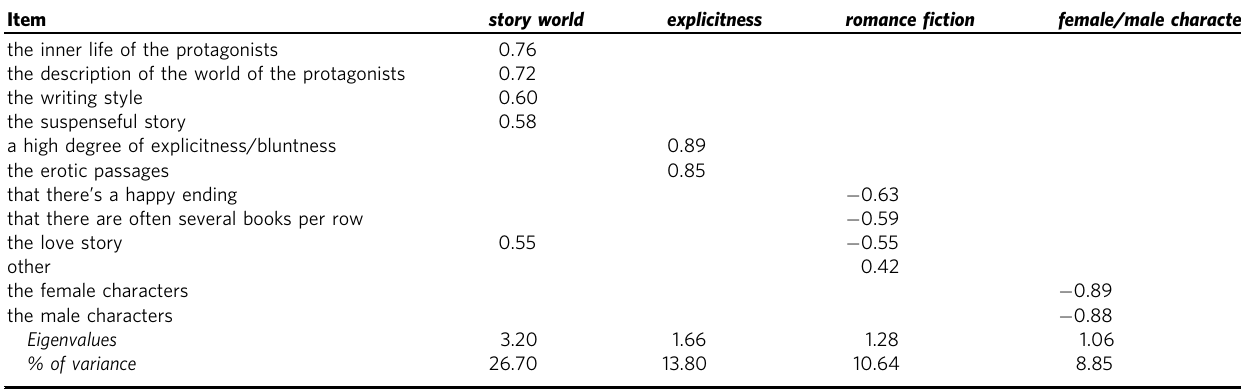
Table 1 Component loadings for a principle components analysis (PCA) with oblimin rotation of the items describing important features of erotic novels ( N =